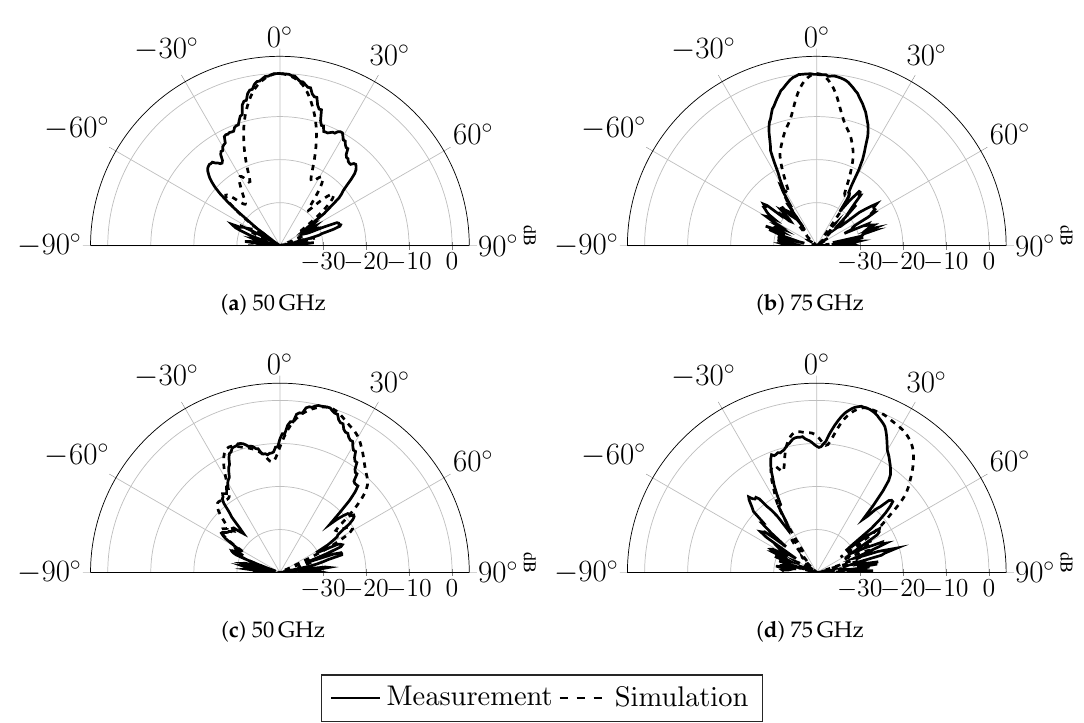
Figure 50. Pattern of the dielectric lens antenna [47] for ( a , b ) θ beam = 0° and for ( c , d ) θ beam = 20°.